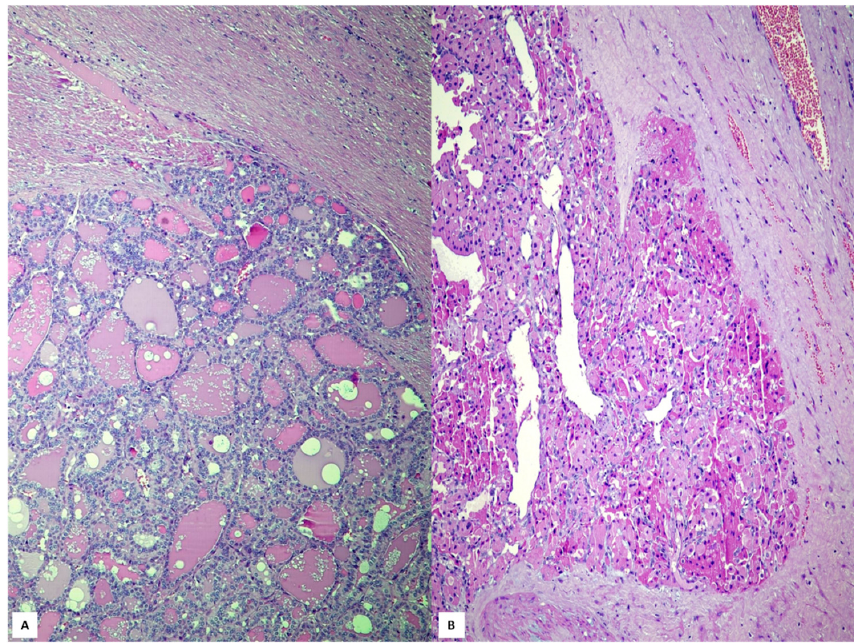
Figure 4. The follicular thyroid carcinoma with minimally invasive capsular infiltration (( A ), he- matoxylin and eosin, 80×); malignant Hürthle cell tumor characterized by an evident capsular in- vasion (( B ), hematoxylin and eosin, 100×). (( B ), hematoxylin and eosin, 100 × ).